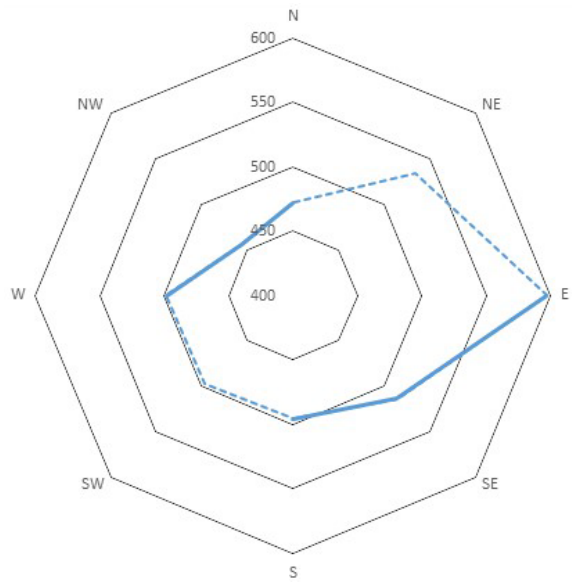
Figure 6. Surficial snow density (kgm − 3 ) according to aspect in the studied snow patches on Fildes Peninsula. Dashed line represents estimated values at NE and SW calculated by averaging between neighbouring orientations.